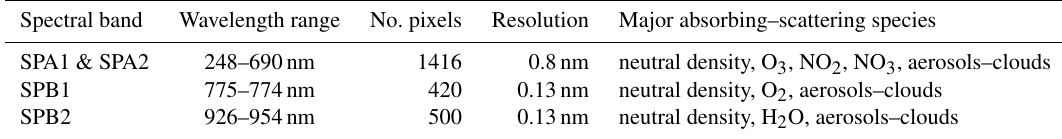
Table 1. GOMOS spectral bands. The number of pixels for each band and the optically active species are also indicated. Spectral band Wavelength range No. pixels Resolution Major absorbing–scattering species SPA1 & SPA2 248–690nm 1416 0.8nm neutral density, O 3 , NO 2 , NO 3 , aerosols–clouds SPB1 775–774nm 420 0.13nm neutral density, O 2 , aerosols–clouds SPB2 926–954nm 500